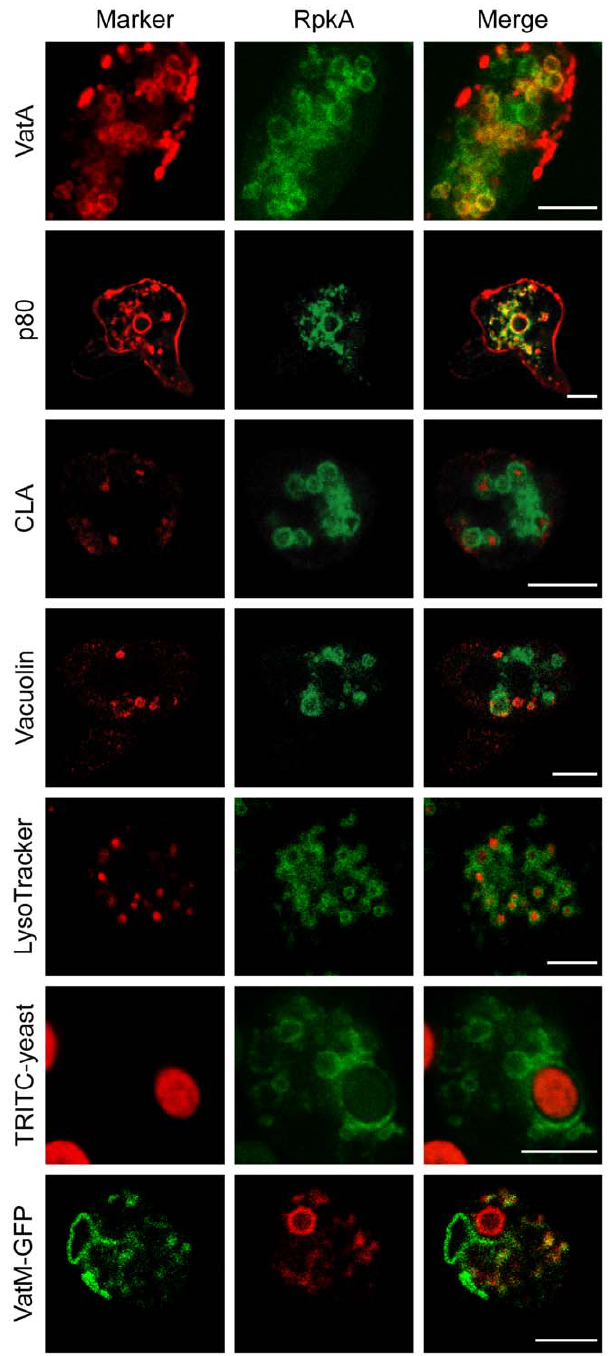
Figure 1. Localization of RpkA-GFP. RpkA-GFP expressing AX2 cells fixed with methanol were labeled with monoclonal mouse antibodies against subunit A of the vacuolar H + -ATPase, VatA (mAb 221-35-2), the putative copper transporter p80 (mAb H161), the common lysosomal antigen CLA (mAb 221-450-6) and the post-lysosomal marker vacuolin (mAb 263-79-2). As secondary antibody a goat-anti-mouse-IgG conju- gated with Alexa 568 was used. Presence of RpkA-GFP in living AX2 cells on acidic compartments was identified by LysoTracker-Red. RpkA-GFP expressing cells were incubated for 15 min with TRITC-labeled S. cerevisiae and fixed with methanol. rpkA 2 cells expressing VatM-GFP and RpkA-RFP. Images were collected using the LSM confocal laser scanning microscope. Scale bar, 5 m